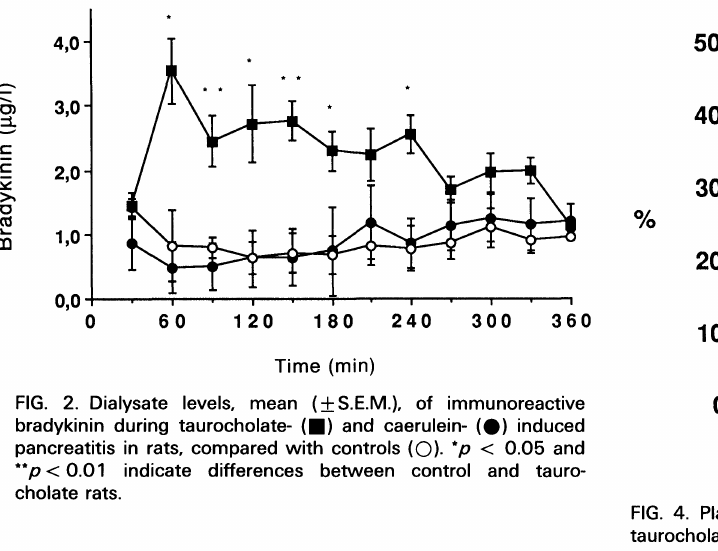
FIG. 4. Plasma levels, mean (JrS.E.M.), of 2-AP in rats during taurocholate-() and caerulein- (O) induced pancreatitis and in control animals ((C)). *p < 0.05 and **p < 0.01 indicate differ- ences between control rats and rats with